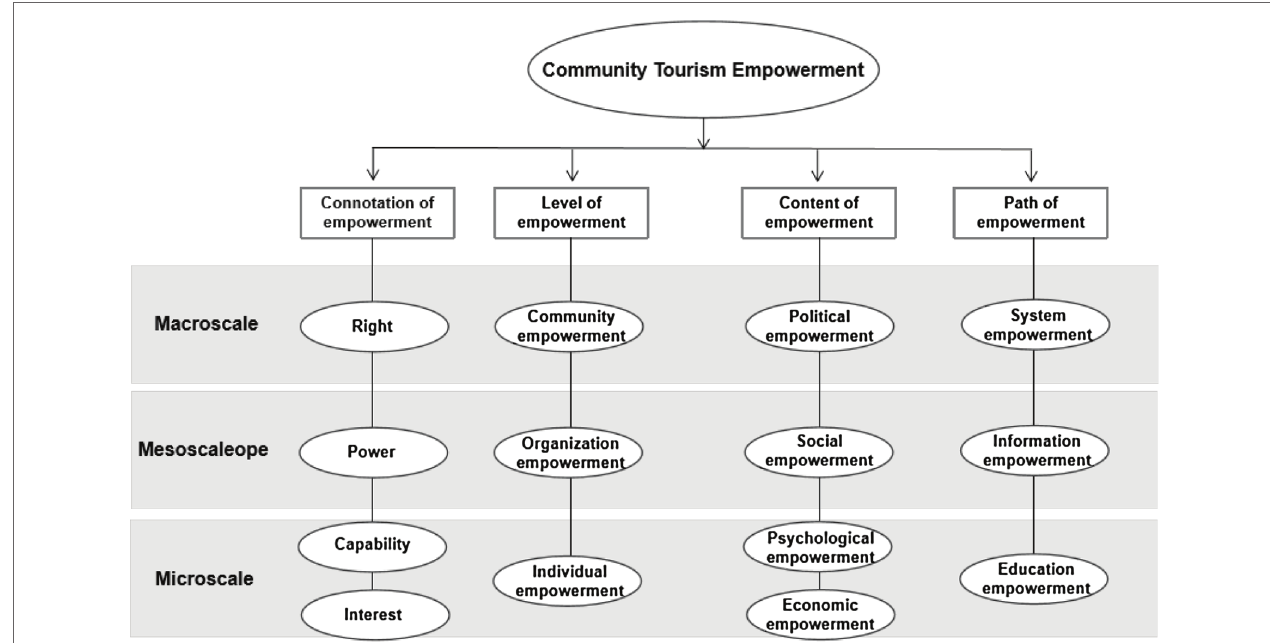
FIGURE 1 | Theoretical framework of community empowerment in